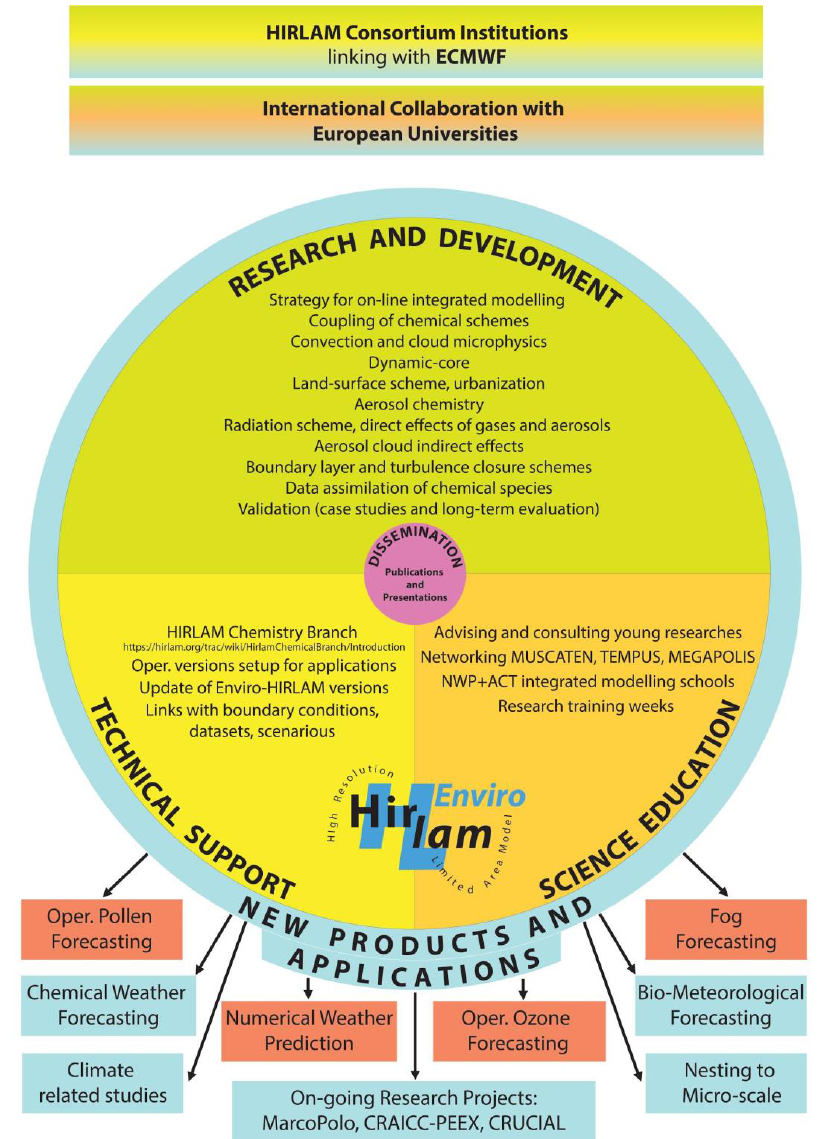
Figure 1. General scheme of international collaboration, research and development, technical support and science education for the online integrated Enviro-HIRLAM: “Environment – High Resolution Limited Area